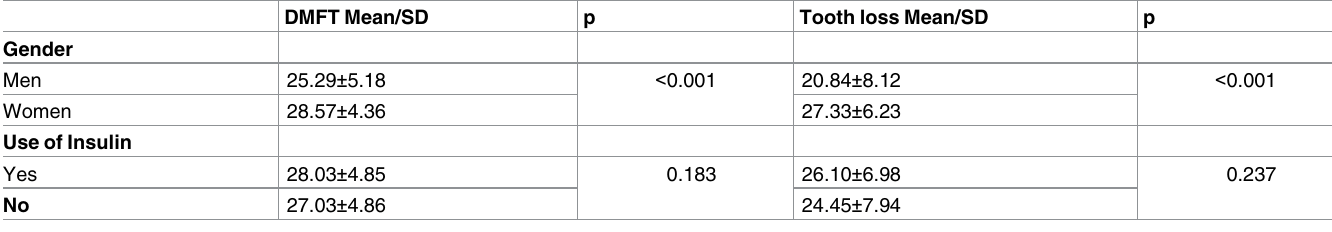
Table 3. Distribution of the DMFT index and tooth loss by gender and use of